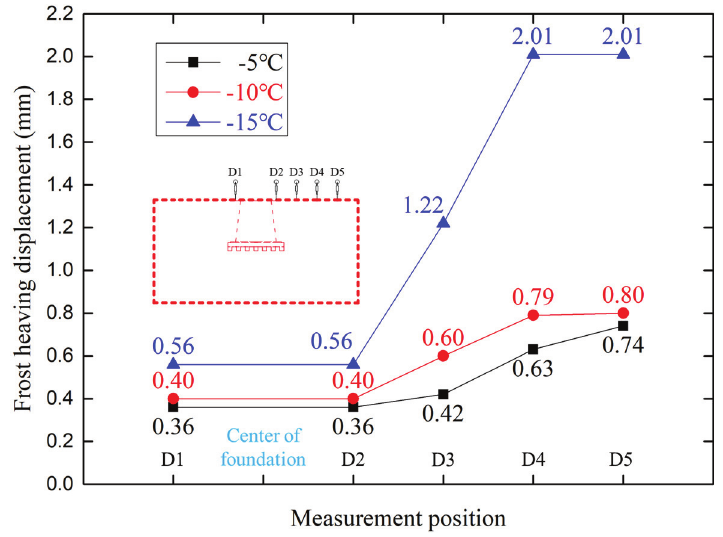
Figure 8. Frost heaving displacement of test pier and frozen soil surface.